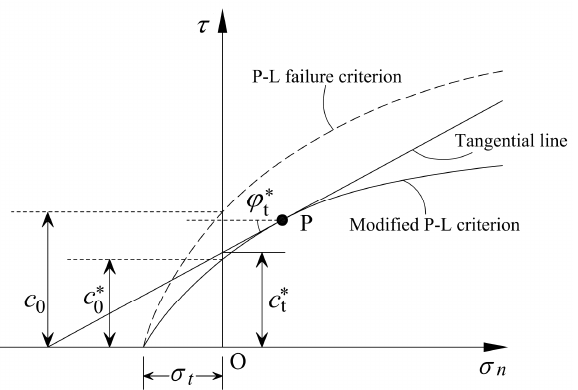
Figure 1. The modified power law strength envelope and corresponding tangential line.